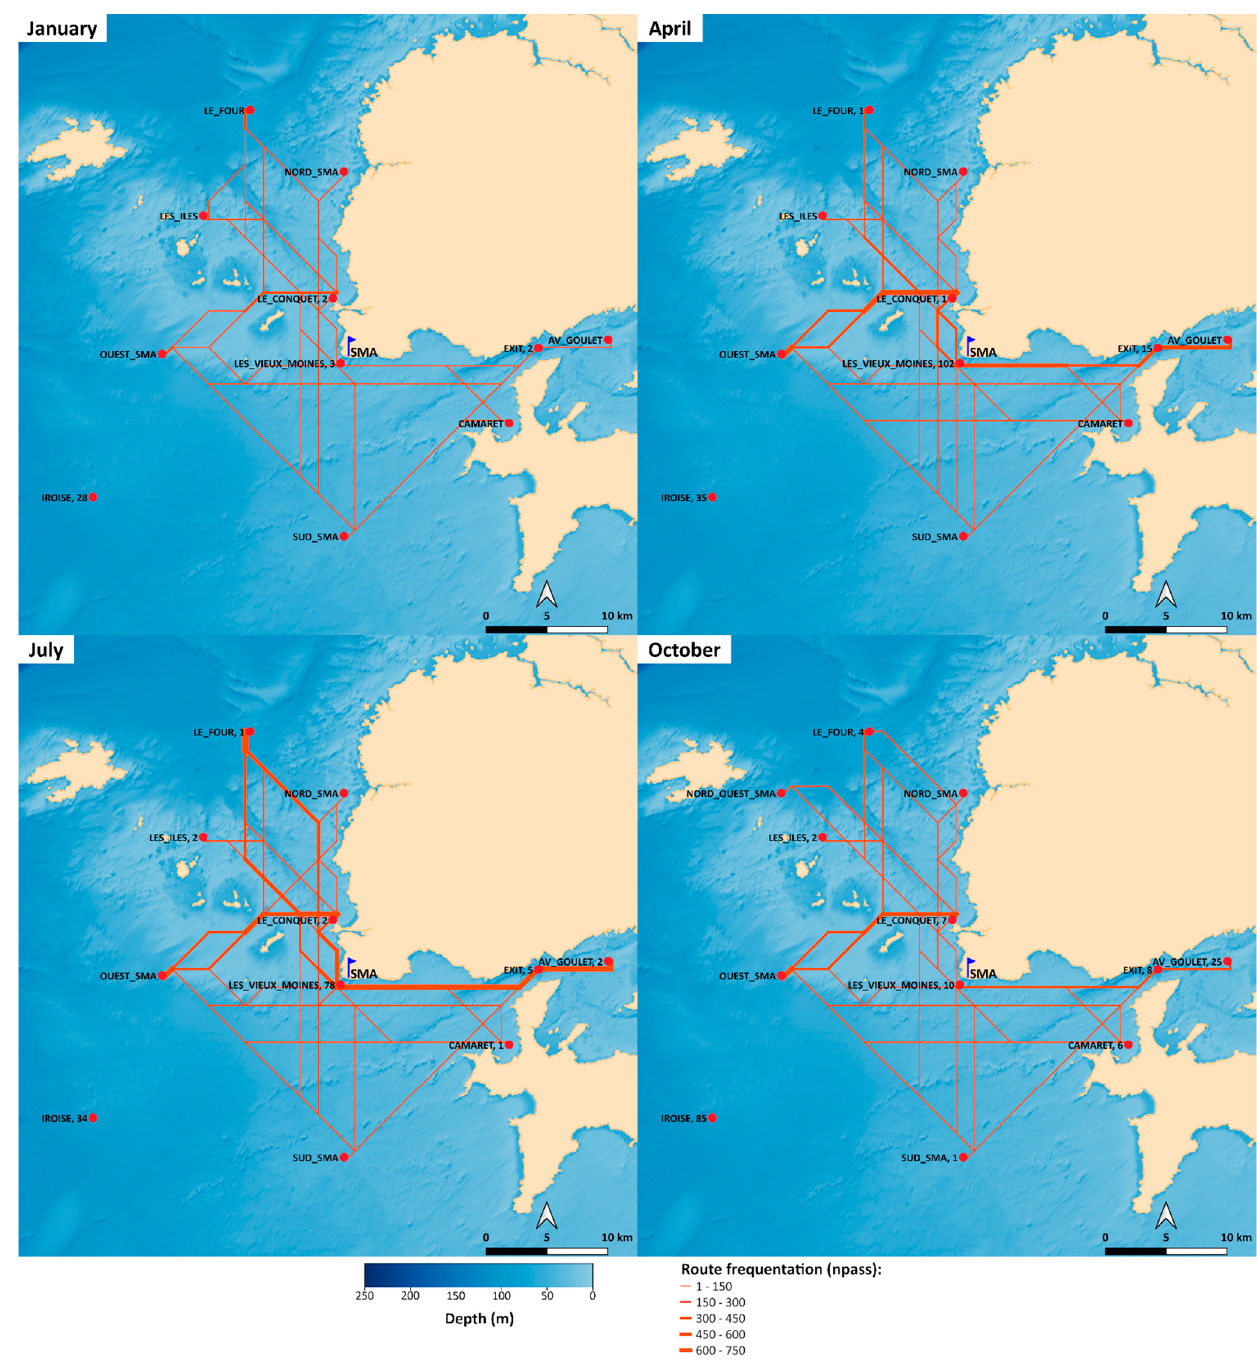
Figure 13. Screenshots of a sample result in output from t.vect.createRoutes.py for the “period” mode at a monthly rate. Samples for each season of 2011 and the Saint-Mathieu sémaphore are reported. A complete version of this image (with all the 12 months for the year 2011) is available in the supplementary file.